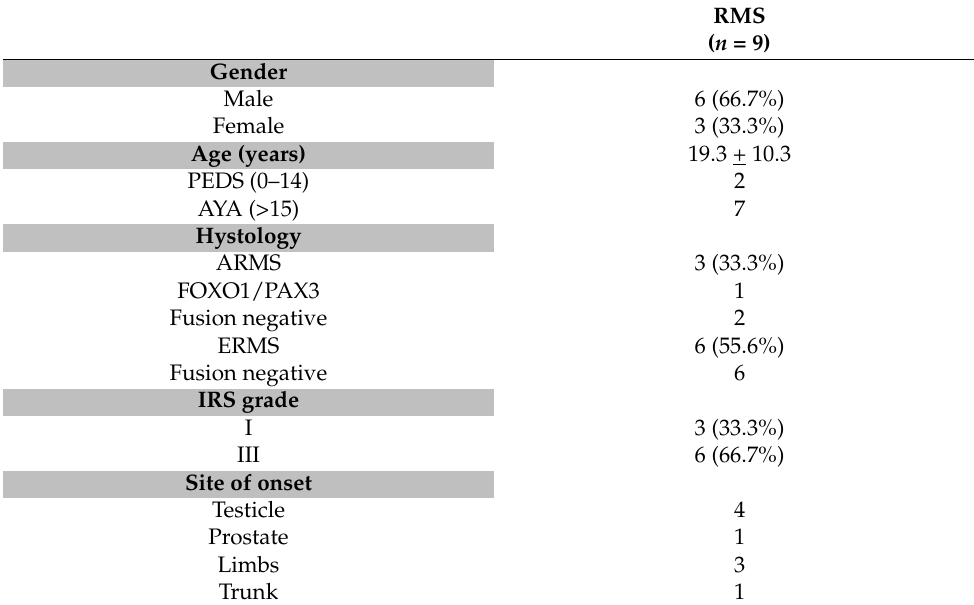
Table 1. Clinical characteristics of RMS